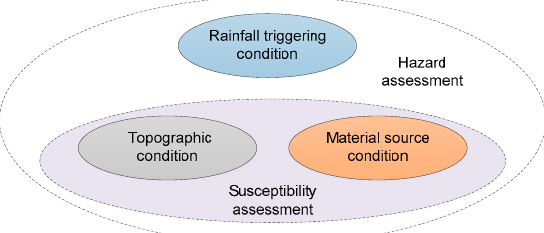
Figure 3. Relationships of rainfall excitation conditions, topographic conditions and material source conditions in debris flow susceptibility and hazard assessment. When only susceptibility assessment is conducted, topographic and material source conditions are the main control factors, while the impact of the rainfall triggering factor should be considered when conducting the debris flow hazard assessment [25].